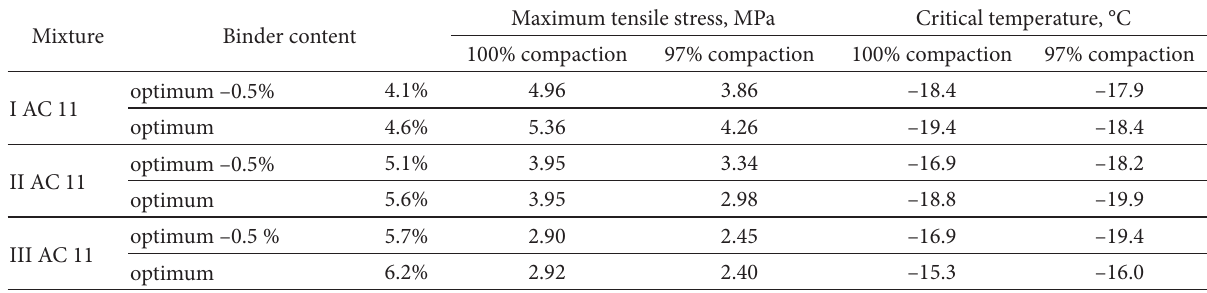
Table 7. Low temperature properties of AC 16 type mixtures